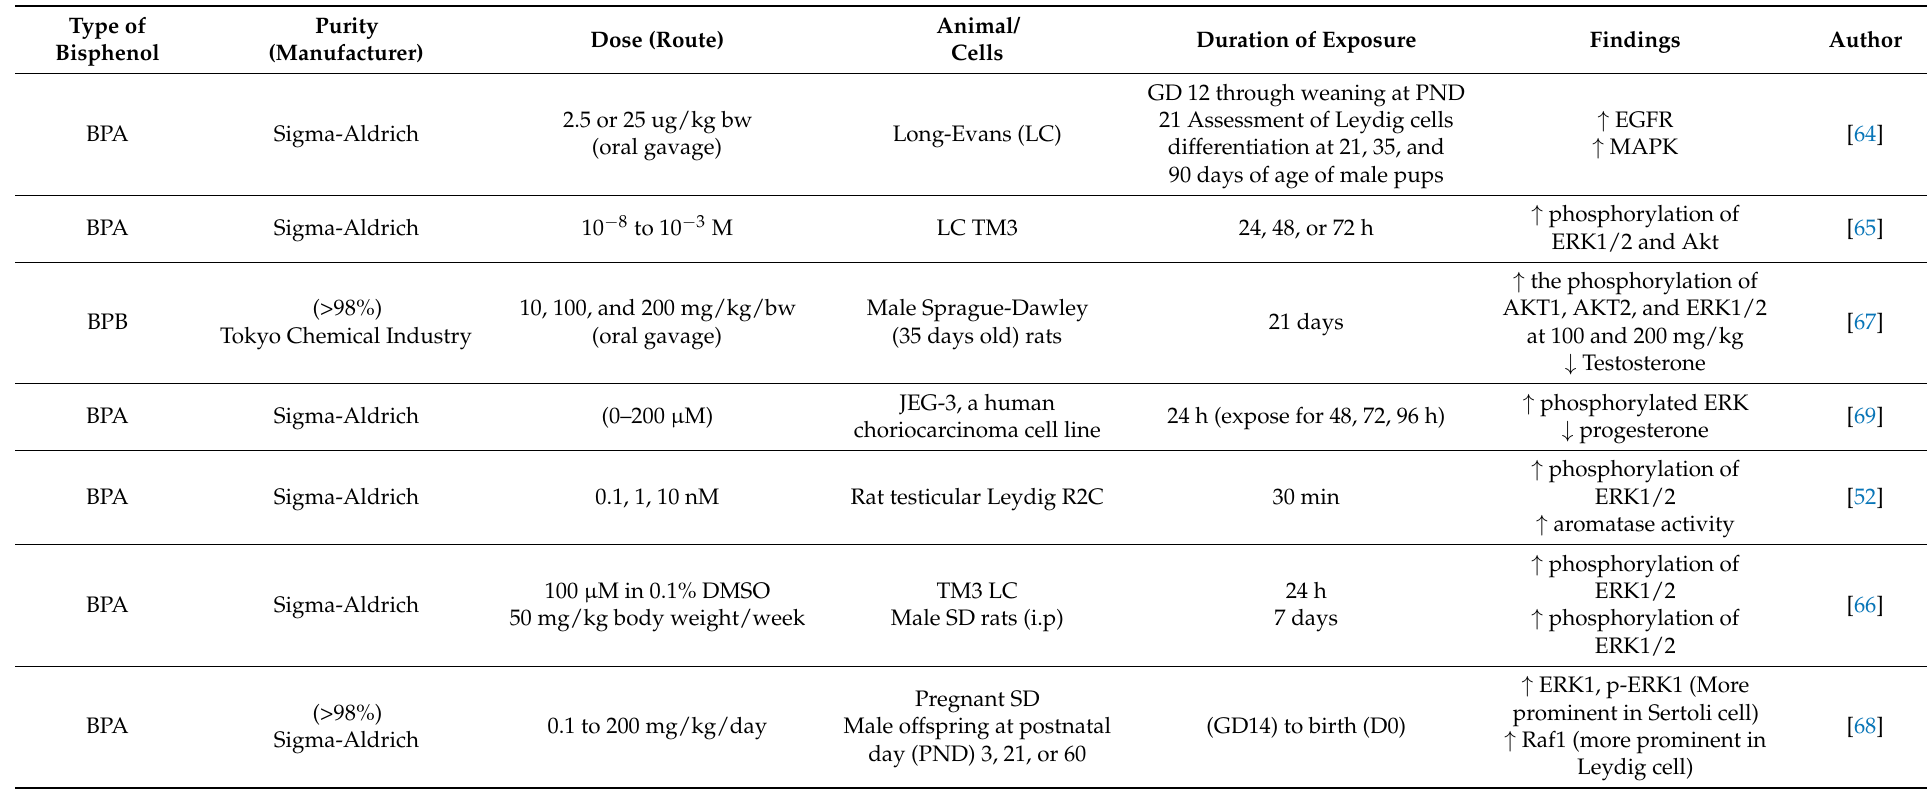
Table 3. The effects of BPA and its analogues on the EGFR-MAPK-ERK signaling pathway in the male reproductive system. Abbreviations: ↑ Increase; ↓